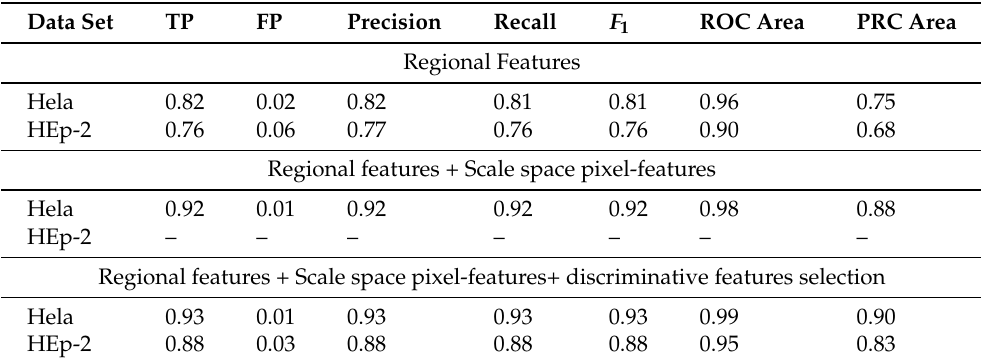
Table 9. Comparison of mean average true positive rate (TP), false positive rate (FP), precision, recall, F 1 score, ROC area and PR area of different classification approaches in different data sets.